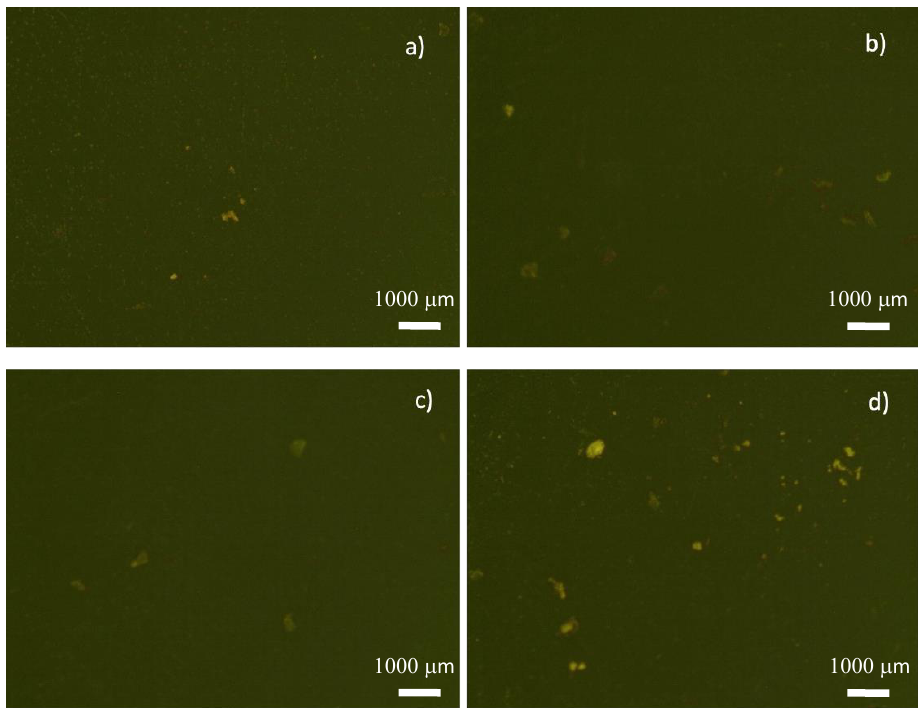
Figure 2. Fluorescence microscopy images of asphalt mix with pistachio shell particles: ( a ) P2, ( b ) P4, ( c ) P6, and ( d ) P8.